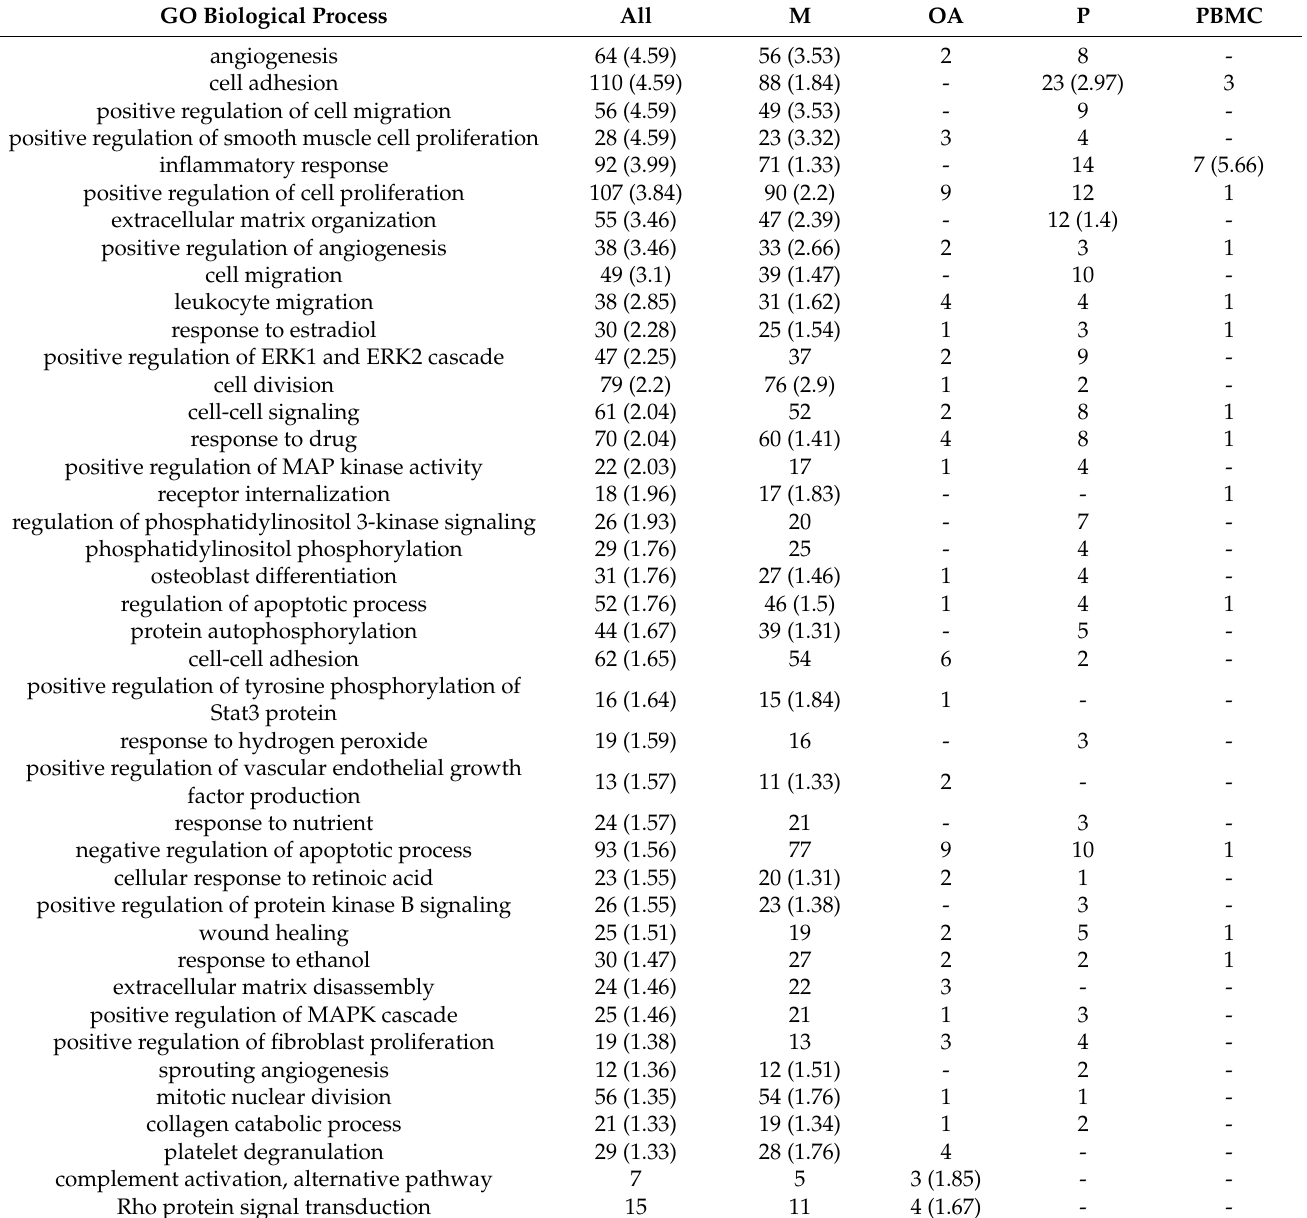
Table 2. Top enriched GO biological processes. The numbers of DEGs assigned to the respective categories are provided next to the − log10 (adjusted p -value) in brackets for those categories showing significant enrichment. M = mesothelial cell DEGs; OA = omental arteriole DEGs, and P = peritoneal cell DEGs; PBMC